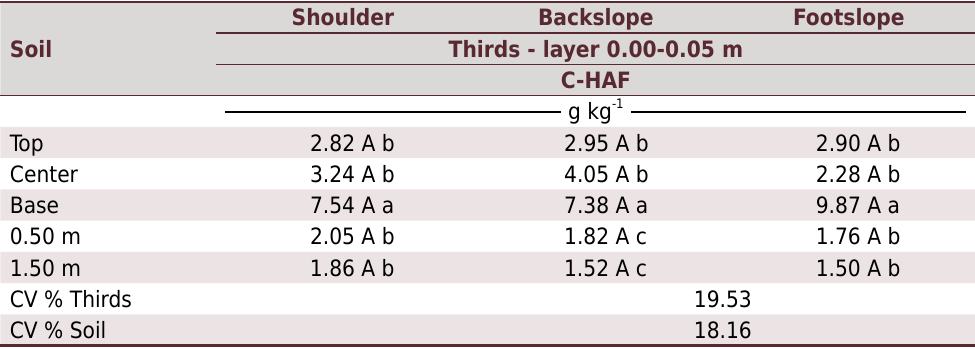
Table 6. Carbon content in humic acid fractions (C-HAF) and carbon from the fulvic acid fraction (C-FAF) in termite mounds and adjacent soils in the Mar de Morros region, Municipality of Pinheiral, Rio de Janeiro State